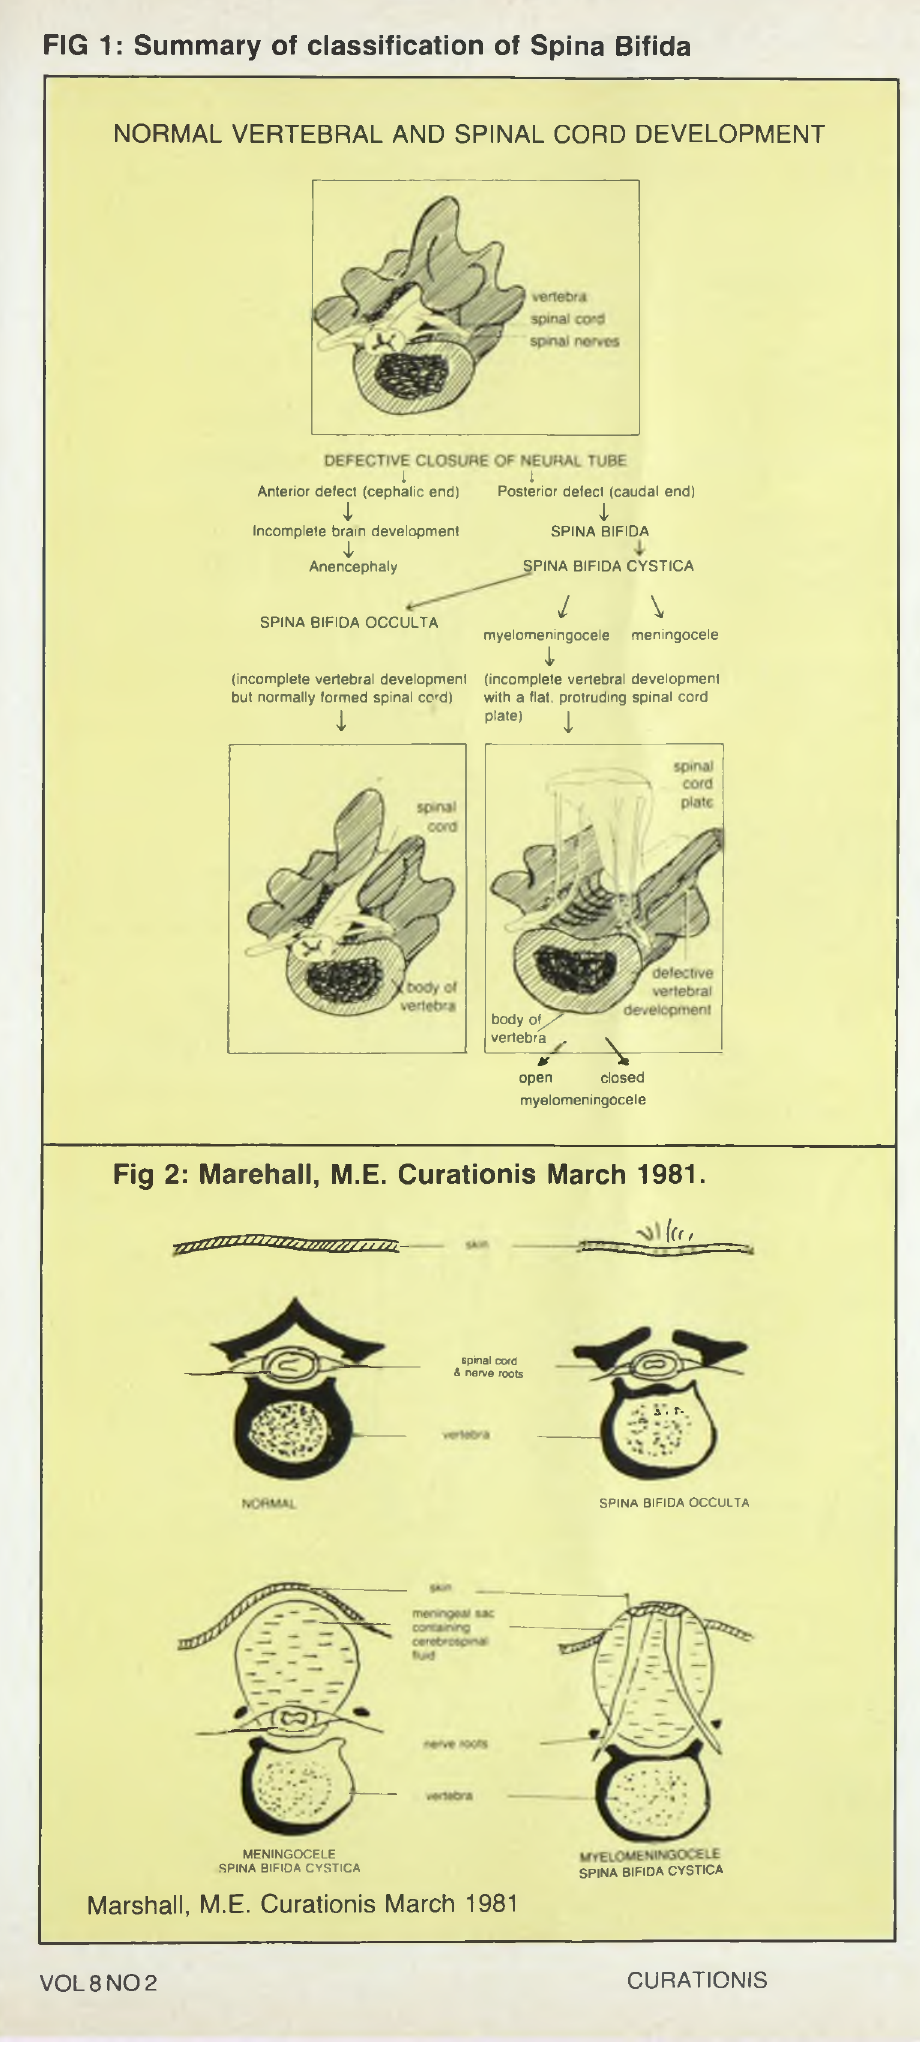
FIG 1: Summary of classification of Spina Bifida Spina bifida occulta